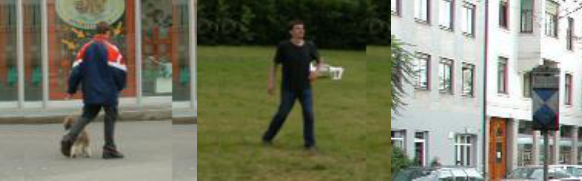
Figure 4. Some examples of INRIA dataset